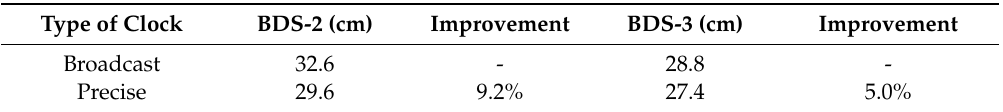
Figure 14. The daily accuracy of the clock offset of each satellite estimated from the broadcast and predicted clocks on DOY 60. Table 6. The average daily accuracy of the ultra-rapid orbit resulting from two types of clocks and the corresponding improvement.